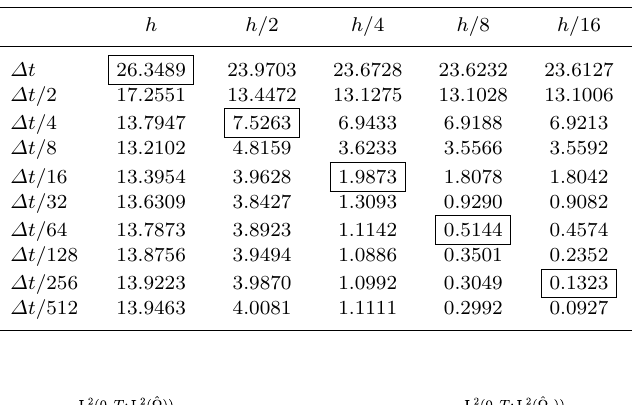
Table 2. Percentage errors for E in the L 2 (0 ,T ;L 2 ( Ω ∆t = 0 . 025.